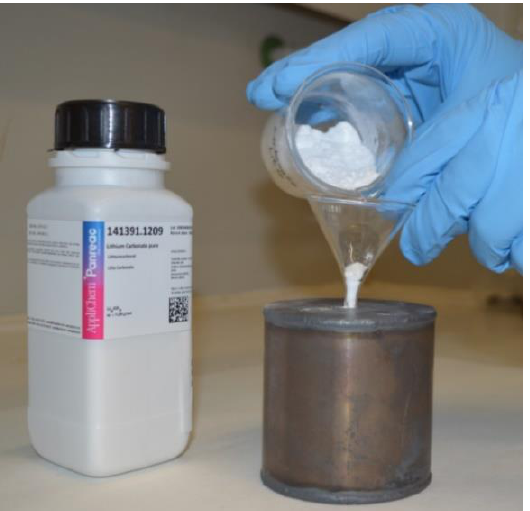
Figure 2. Filling the container with lithium carbonate following several steps to assure the PCM deaeration.